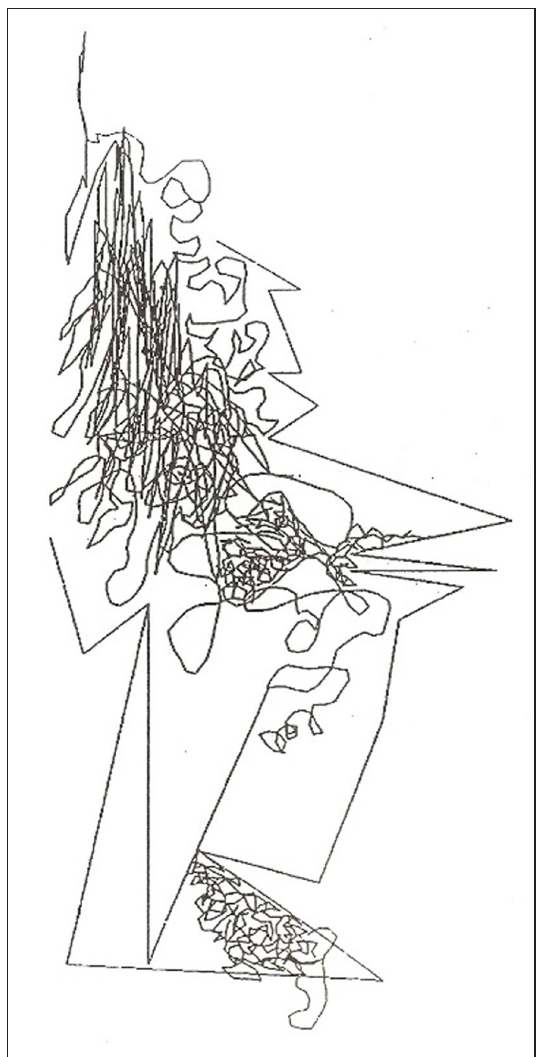
Figure 6: Jennifer Pike, from Computer Dances , 29. Courtesy of David